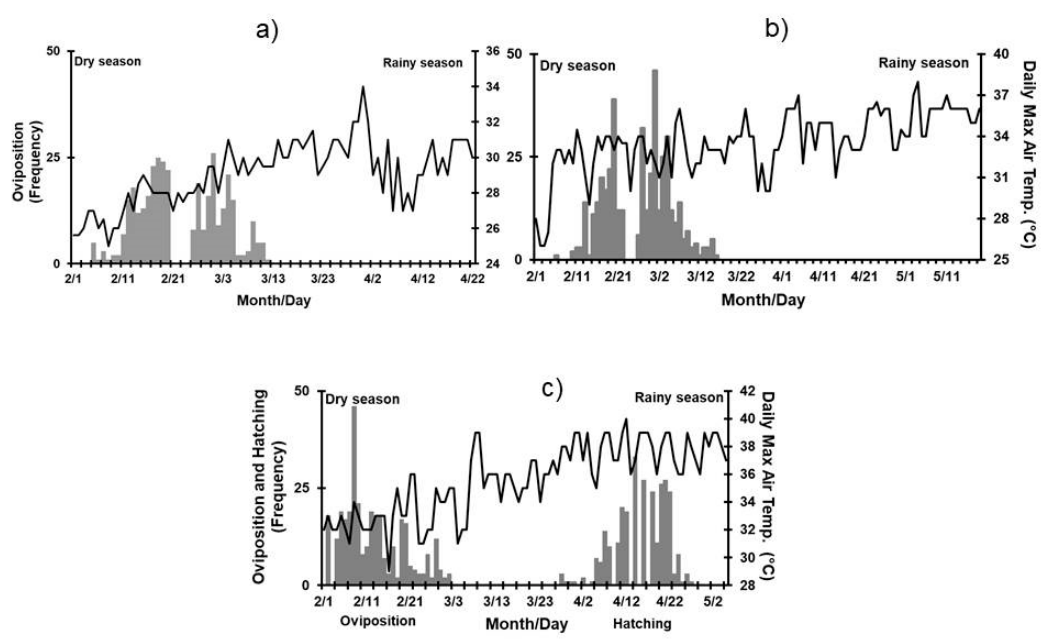
Figure 5. Seasonality in daily maximum air temperature (solid black line) and nest numbers (grey bars at the left side) with increasing temperatures over the three reproductive seasons: ( a ) 1999, ( b ) 2000, and ( c ) 2001. Fluctuations are more marked in some years than others. For year 2001, grey bars at the right side represent the hatching portion.